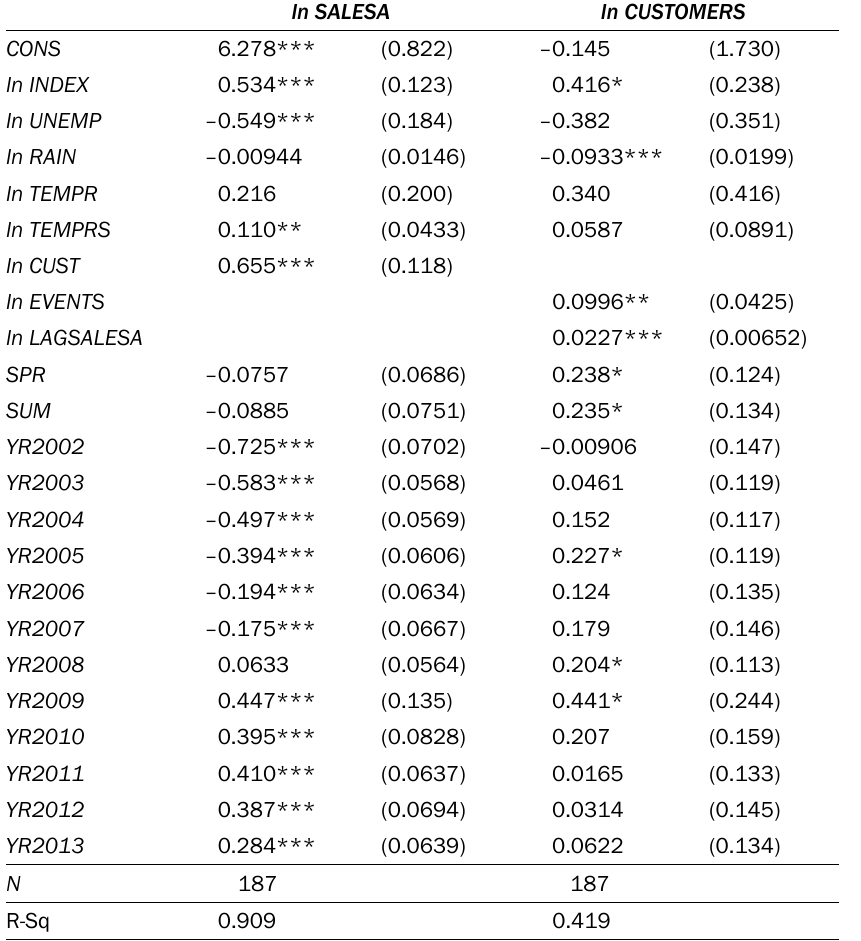
Table 4. Joint Estimation of Sales and Customers Using a Three-Stage Least Squares Simultaneous Regression Approach Model